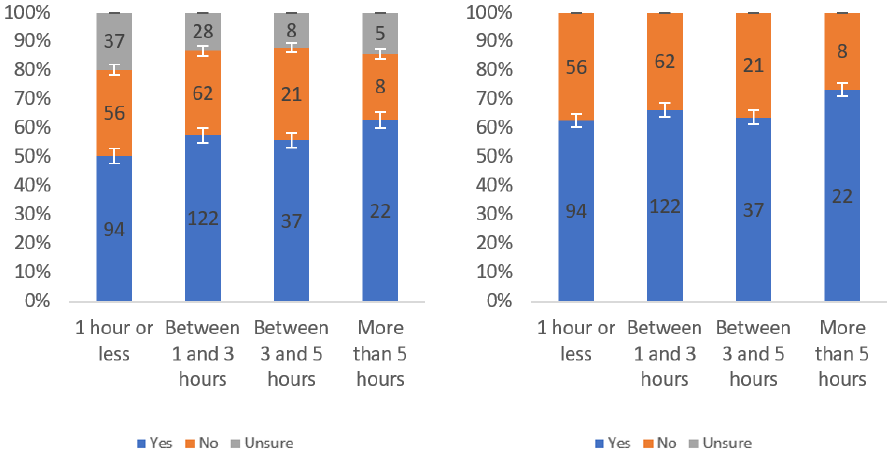
Figure A39. Responses regarding respondents’ willingness to review by internet usage level including ( left ) and excluding ( right ) unsure responses.